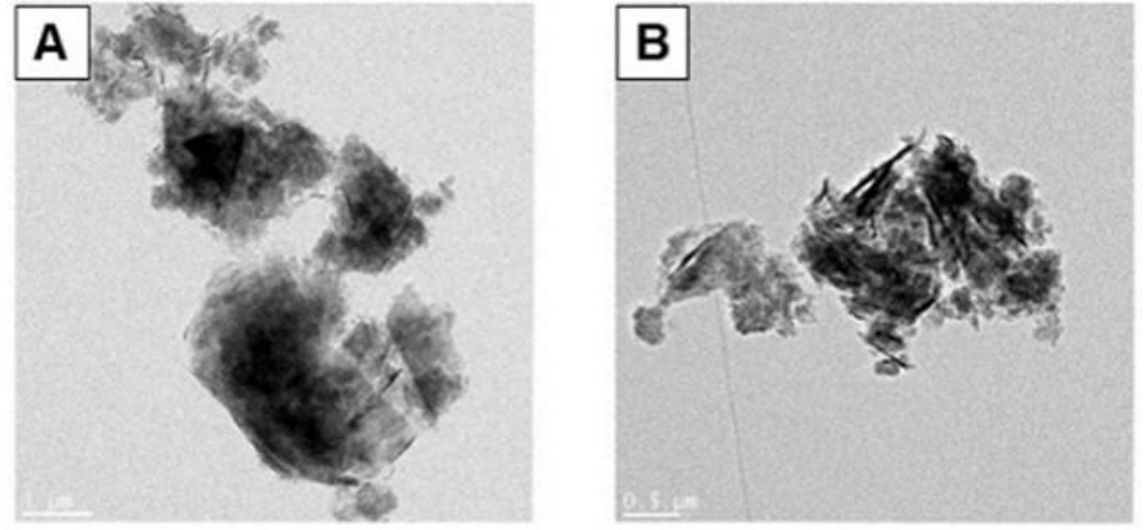
Figure 1. Morphological images of differential graphene nanomaterials observed by transmission electron microscopy. ( A ) GNPs-1 (300 m 2 /g, bar = 1 µ m) and ( B ) GNPs-2 (500 m 2 /g, bar = 0.5 µ